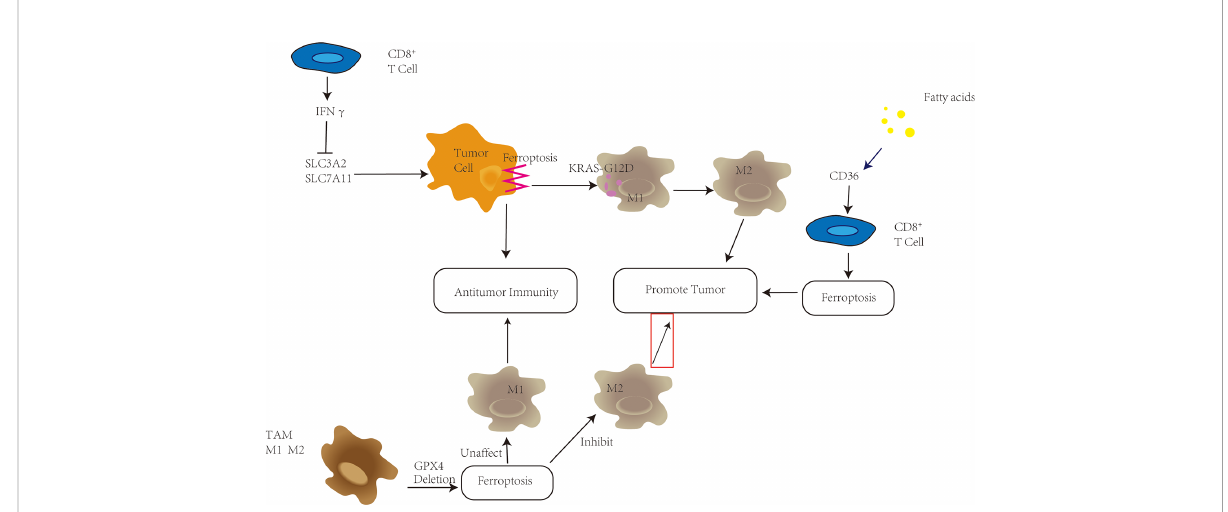
FIGURE 2 Ferroptosis plays a variety of roles in the tumor microenvironment (TME). CD8 + T cells in the TME have been shown to secrete IFN g , which inhibits SLC3A2 and SLC7A11, promotes tumor cell ferroptosis, and improves antitumor immunity. High fatty acid levels in the TME, on the other hand, enhance CD36 upregulation, trigger ferroptosis in CD8 + T cells, and hasten tumor growth. Depletion of GPX4 in tumor-associated macrophages (TAMs) can reduce M2-type macrophage survival while increasing antitumor immunity without changing the amount of M1-type macrophages. KRAS-G12D is released pancreatic cells undergo ferroptosis, promoting the transition of macrophages into M2 type and tumor